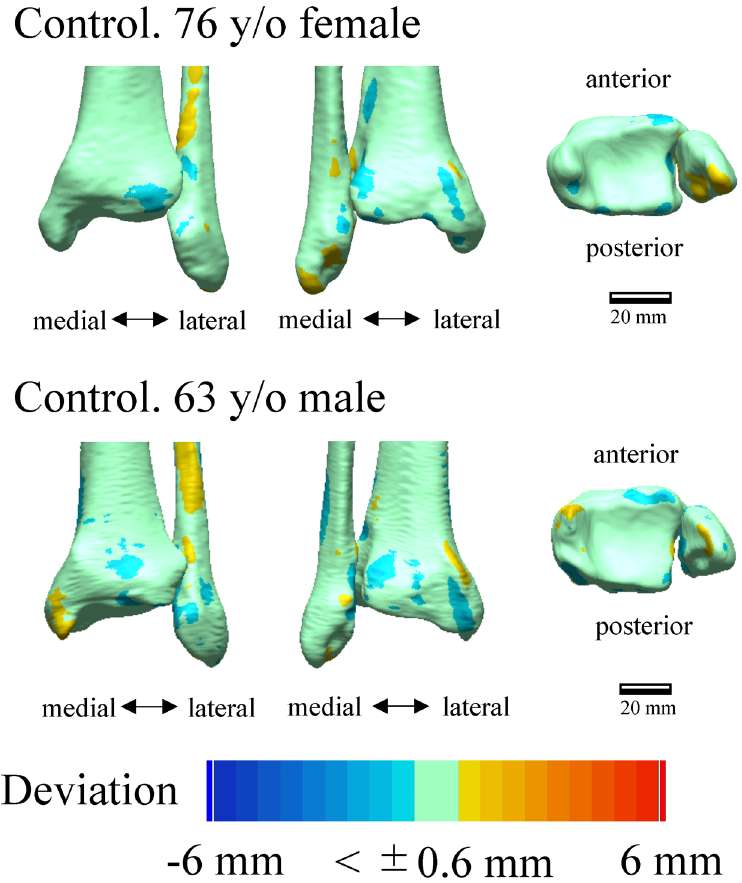
Figure 1. Deviation color maps of left–right comparisons of the tibia and fibula in the control group. Two representative examples are presented. The red and blue colors are deviations of the right surface outside and inside of the left surface. 1. Anterior view. 2. Posterior view. 3. Inferior view. y/o = years